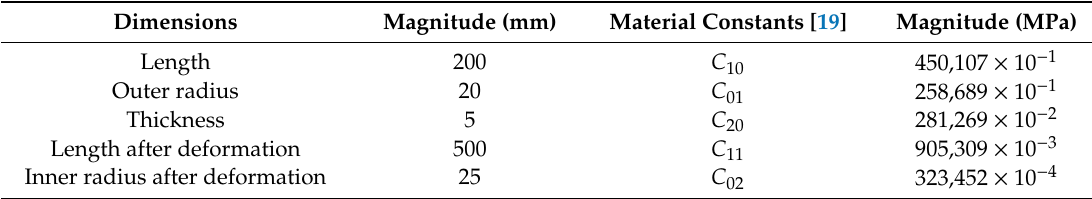
Table 1. Example parameters of the cylinder.